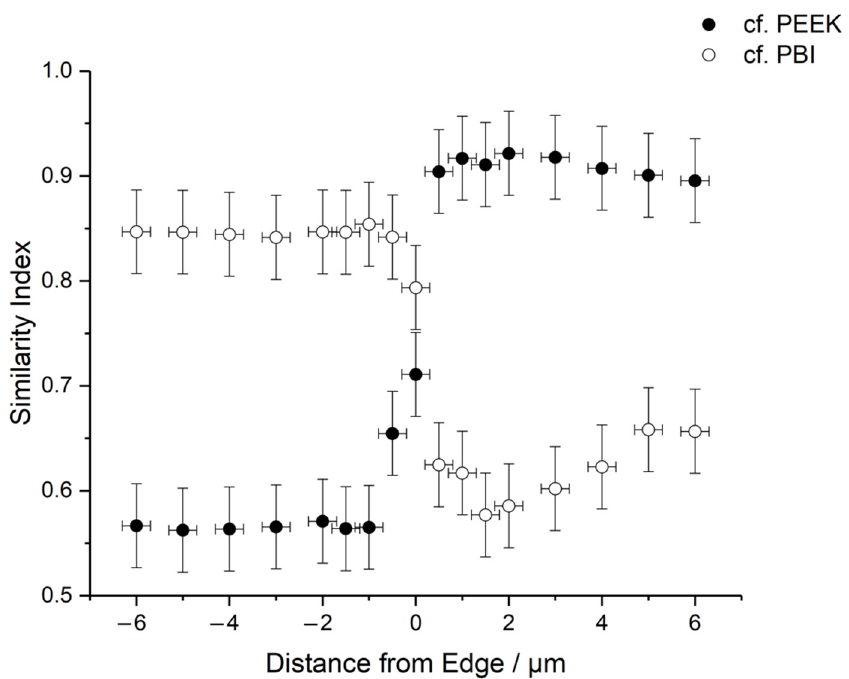
Figure A4. Combined similarity indices derived from both the 1134–1440 cm − 1 and 1460–1700 cm − 1 regions of the AFM-IR PPB spectra shown in Figure 4 and the AFM-IR spectra of pure PEEK and pure PBI.